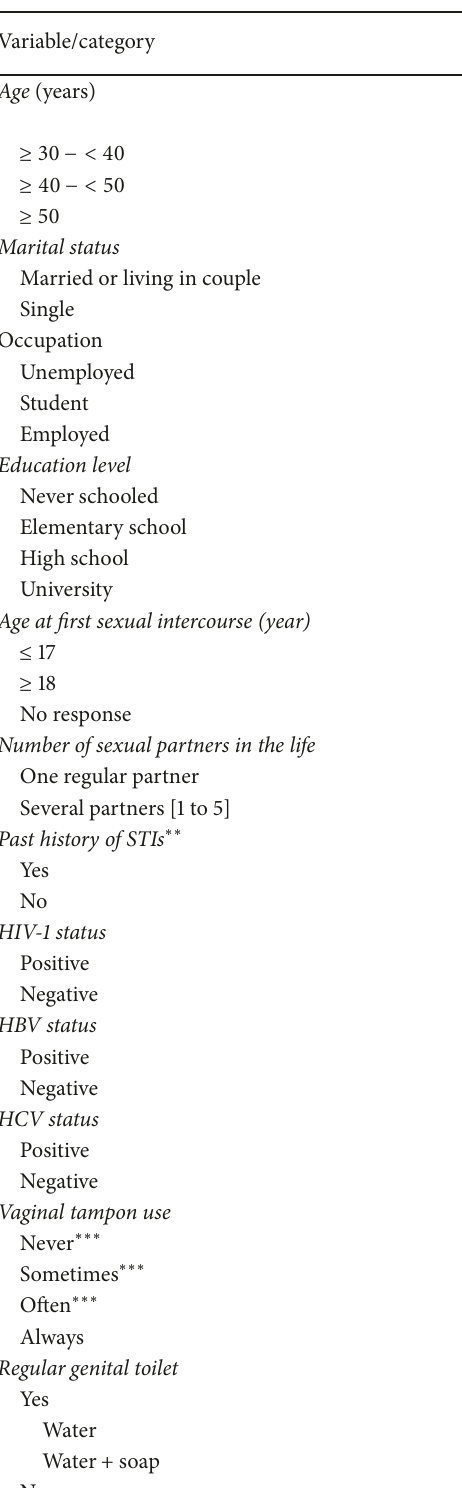
Table 1: Sociodemographics, behavioural, and hygiene characteristics of the 251 women living in N'Djamena, Chad, and recruited from the